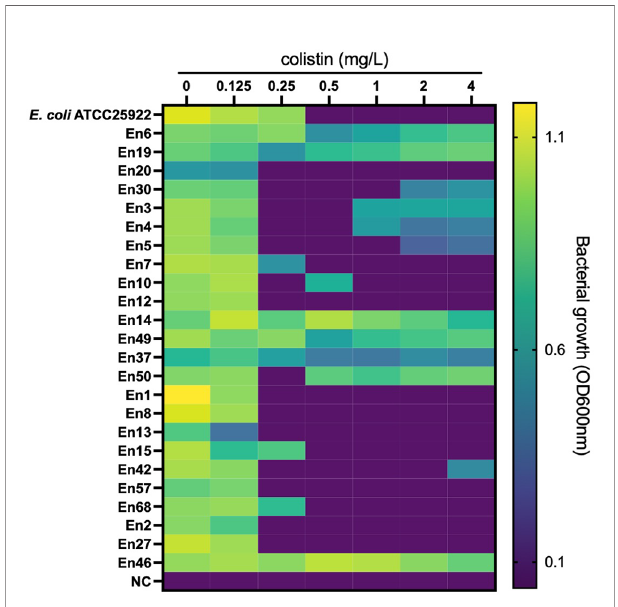
FIGURE 2 | Bacterial growth in colistin-containing medium to evaluate the ‘ skip-well ’ phenomenon in Enterobacter spp. Isolates This method was identical to the broth microdilution method described in the CLSI guidelines. Bacterial growth was determined as turbidity of the medium in cation- adjusted MHII broth at the experimental endpoint (after an 18-h cultivation at 37°C in a 96-well plate). OD 600nm was measured every 10 min for 18 h. An OD 600nm of <0.1 was de fi ned as no